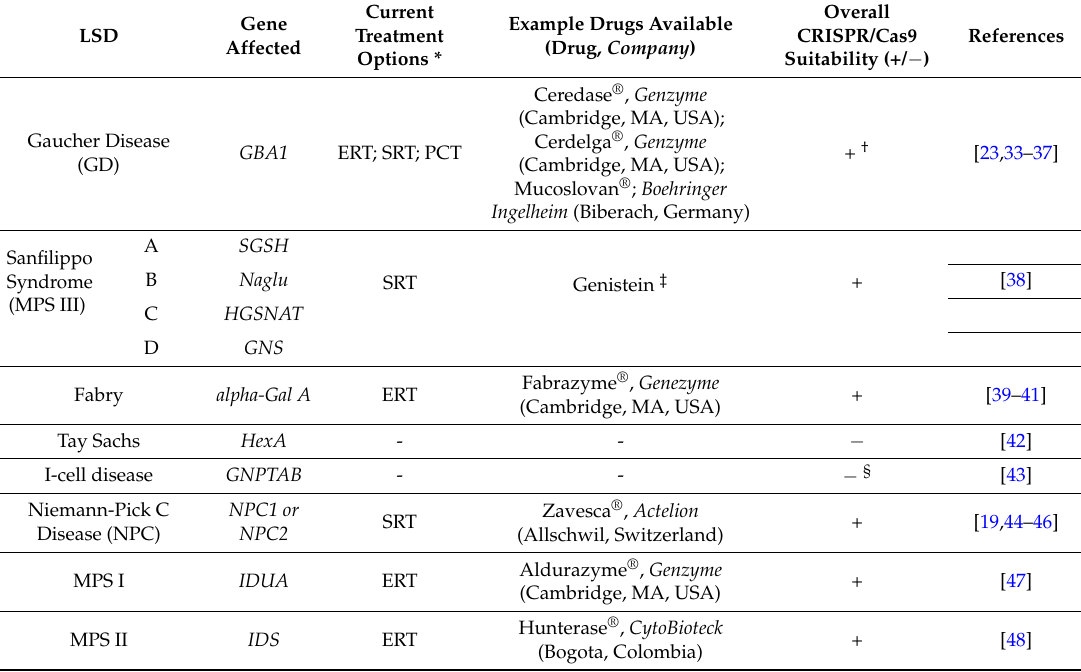
Table 1. Current treatment options available for a number of lysosomal storage diseases (LSDs). Potential use of CRISPR/Cas9 for correction of disease causing mutations is indicated for each LSD